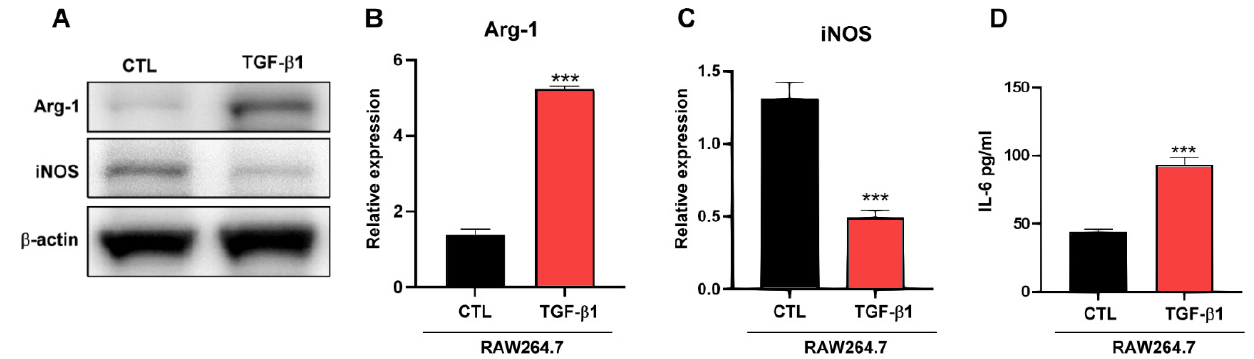
Figure 3. ( A – C ) Arg1 and iNOS protein expression and quantification by Western blotting after treatment of RAW 264.7 cells with 20 ng/mL TGF- β 1 for 48 h. ( D ) IL-6 levels in conditioned media after treatment of RAW 264.7 cells with TGF- β 1. Data are presented as mean ± SEM for four independent experiments. Two-tailed Student’s t -test: *** p < 0.005.